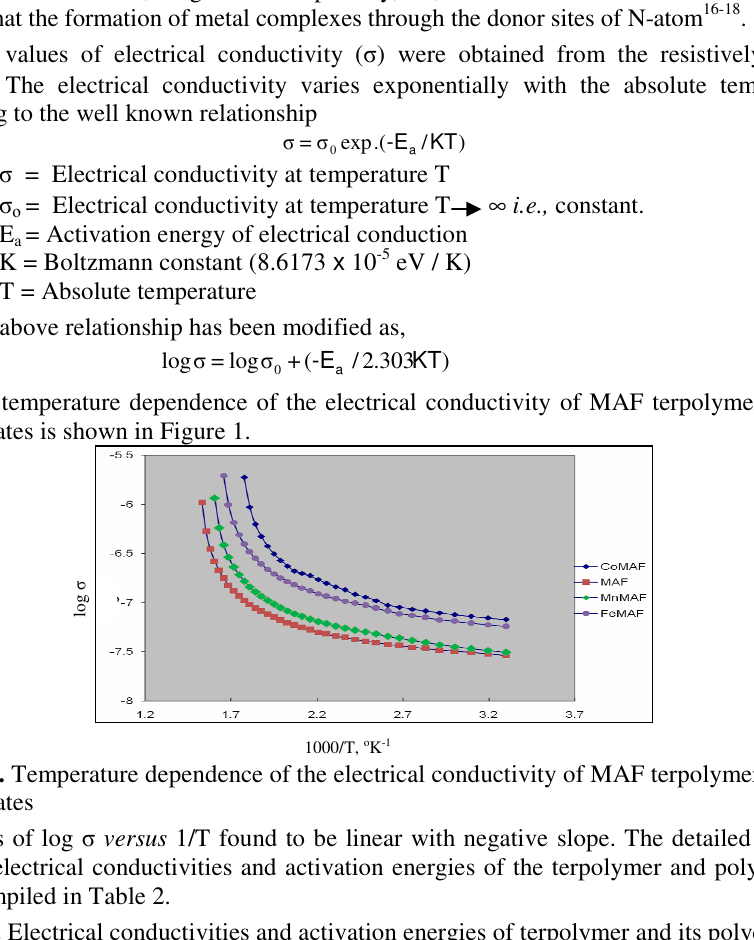
Table 2. Electrical conductivities and activation energies of terpolymer and its polychelates